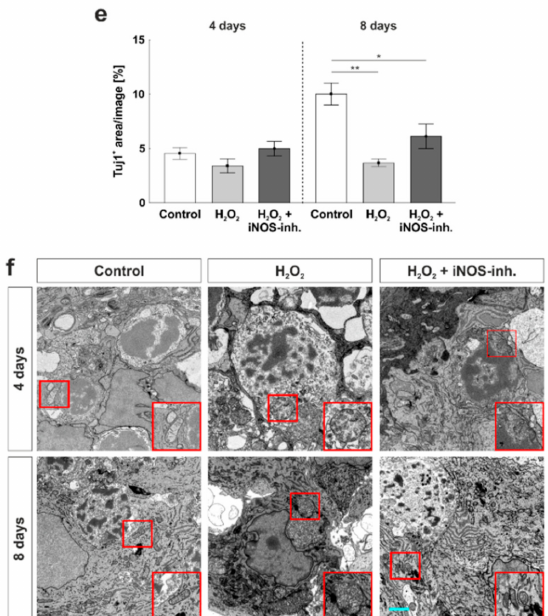
Figure 3. Number and morphology of retinal ganglion cells was protected. ( a ) RGCs were stained with anti-RBPMS (red, upper images) and anti-neurofilament H (red, lower images) at four and eight days. Cell nuclei were labelled with DAPI (blue). ( b ) Cell counts revealed a loss of RGCs at four ( p < 0.001) and eight days ( p = 0.005). This effect was strongly prevented by the iNOS-inhibitor at four days ( p = 0.005) and attenuated at eight days ( p = 0.13). ( c ) At four days, the iNOS-inhibitor led to a significantly increased mRNA expression of TUBB3 (to H 2 O 2 : p = 0.006; to control: p = 0.02). At eight days, no statistical differences were seen within the groups. ( d ) Neuronal marker Tuj1 was used to investigate retinal neurons (green). Cell nuclei were labelled with DAPI (blue). ( e ) At four days, no effect of H 2 O 2 or the iNOS-inhibitor was noted within the groups. At eight days, however, a significant smaller Tuj1 + area was noted in H 2 O 2 ( p = 0.002) as well as in the H 2 O 2 + iNOS-inhibitor treated retinas ( p = 0.03). Still, the Tuj1 + area of the H 2 O 2 + iNOS-inhibitor treated retinas was twice as large as in H 2 O 2 retinas. ( f ) Transmission electron microscopy revealed a preservation from oxidative stress at four and eight days. Cell morphology as well as the cell compartments of RGCs were protected by the iNOS-inhibitor. The red box indicates a mitochondrion of each group whose morphology is intact in the control and iNOS-inhibitor group and swollen in the H 2 O 2 group GCL = ganglion cell layer; IPL = inner plexiform layer. ( a , b ) n = 9–10/group and ( c ) n = 6–8/group; scale bars: ( a , d ) 20 µ m and ( f ): 5 µ m; values are shown as mean ± SEM for immunohistology and mean ± SD for RT-qPCR. * p < 0.05; ** p < 0.01; *** p <